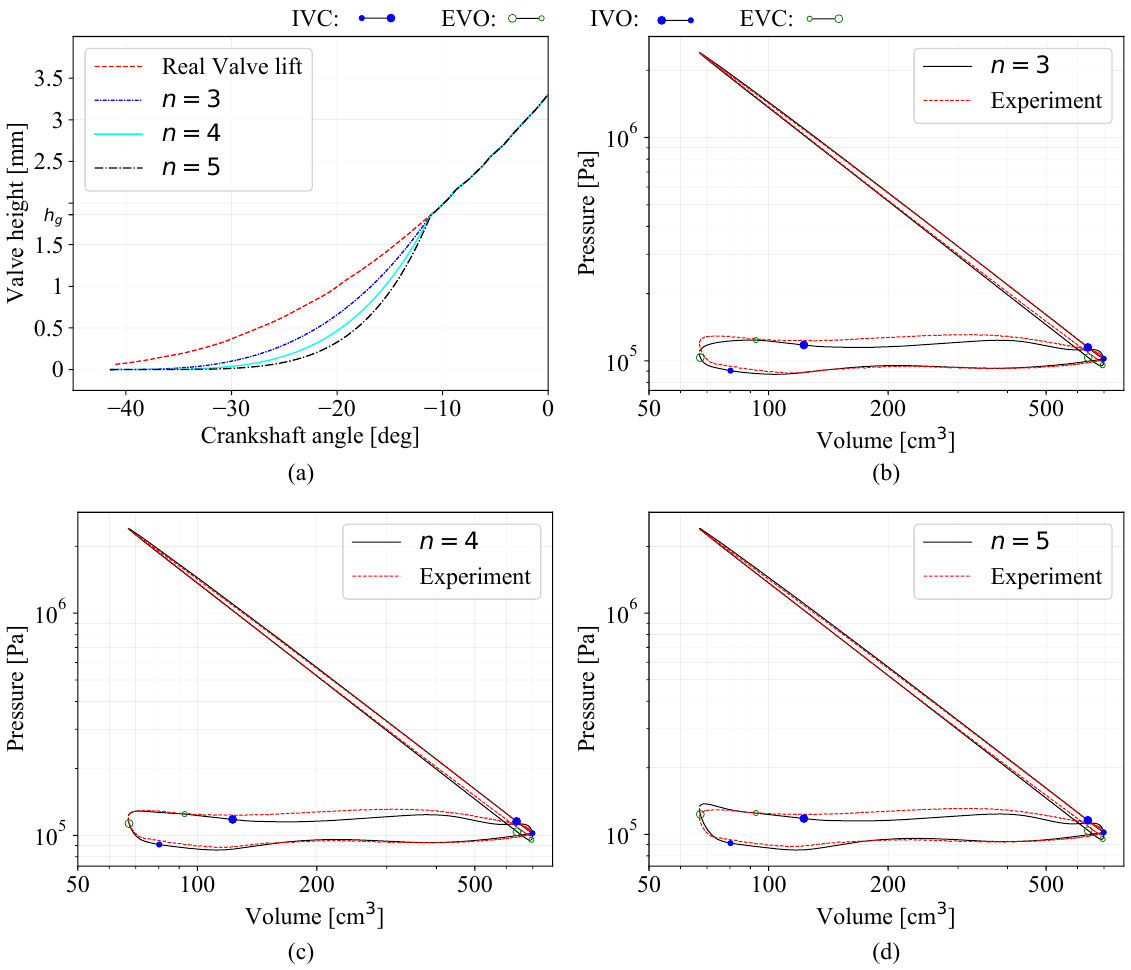
Figure 11. Valve height over time and cylinder pressure results for different values of the parameter n : ( a ) valve height over time ; ( b ) n = 3; ( c ) n = 4; ( d ) n =